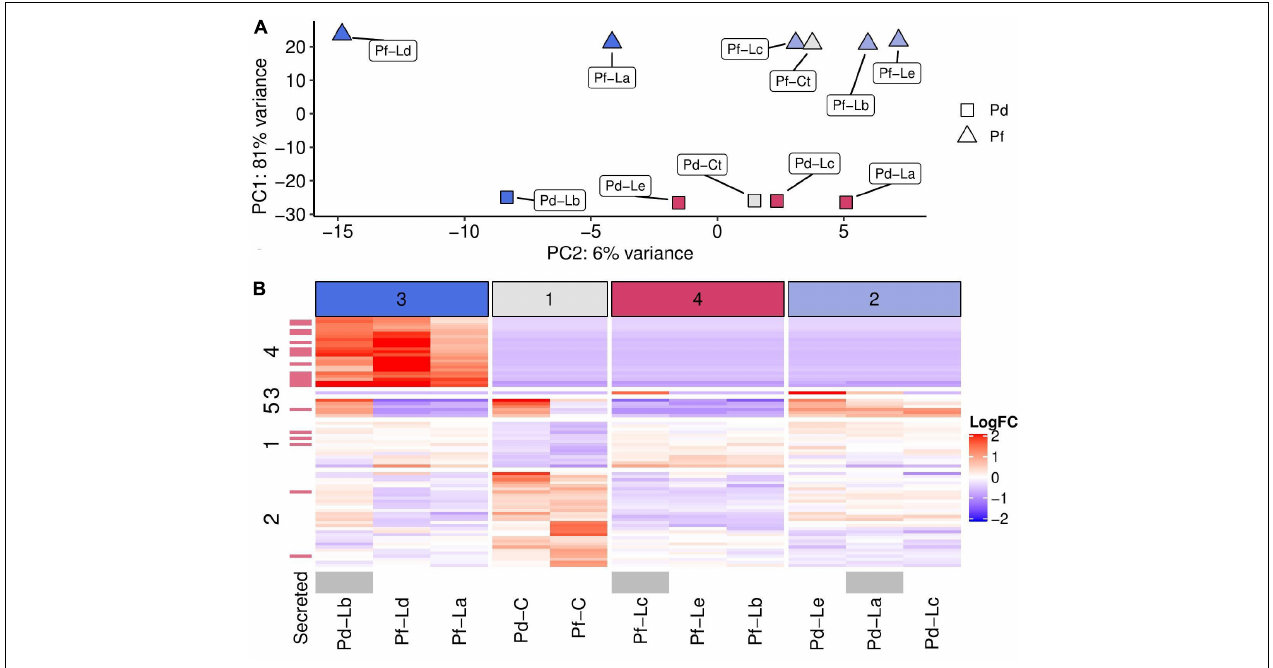
FIGURE 2 | Dominant sources of variation in gene expression between samples. Sample labels in both plots show the Porites genotype (Pd, Pf) followed by Lobophytum genotype (La–Le) or Control (C). (A) Principal components plot showing relative position of samples based on PC1 and PC2. Point shapes indicate the Porites genotype (Pd represented by triangles and Pf by squares) and point colours indicate sample groupings shown as coloured and numbered columns in part B (group 1– grey; group 2–light blue, group 3–dark blue, group 4–red). (B) Heatmap showing log 2 fold change (Log 2 FC) in expression compared to the mean (across all samples) for 76 genes found to be differentially expressed between treatment and control samples. Column clusters are indicated with numerical values and colours (top) and row clusters are labelled numerically (left). Transcripts highlighted in red (left strip) have predicted secretion signals via SignalP in their corresponding protein translations. Samples where mesenteric filaments were observed are shown in grey (bottom